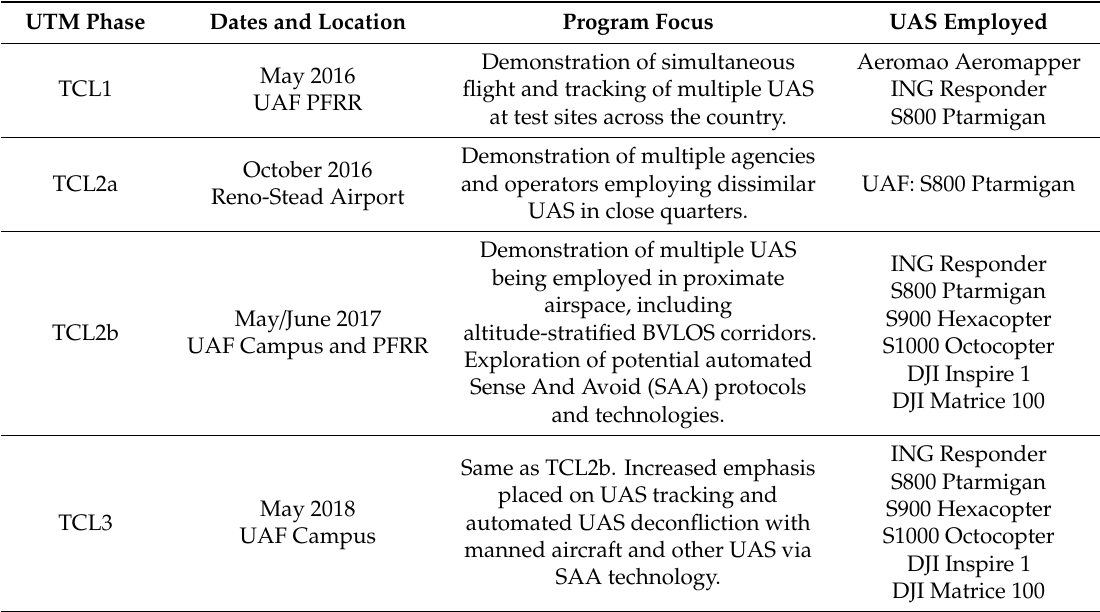
Table 1. UAF/ACUASI participation in UTM TCL1-3 campaigns.